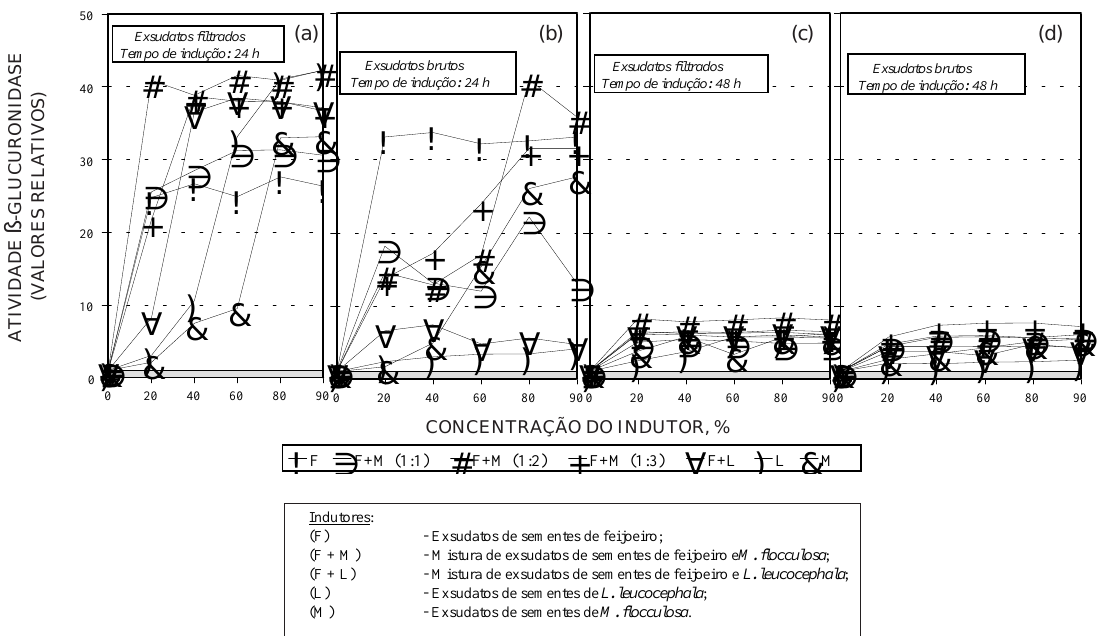
Figura 3. Atividade da enzima ß-glucuronidase, resultante da indução dos genes nod da estirpe CFN (pGUS 32) pela presença de exsudatos de sementes filtrados (a, c) e brutos (b, d), em dois tempos de indução distintos (24 e 48 h). Valores relativos aos controles (culturas de bactérias na ausência de indutores - exsudatos de sementes). Os valores referentes aos controles são iguais a